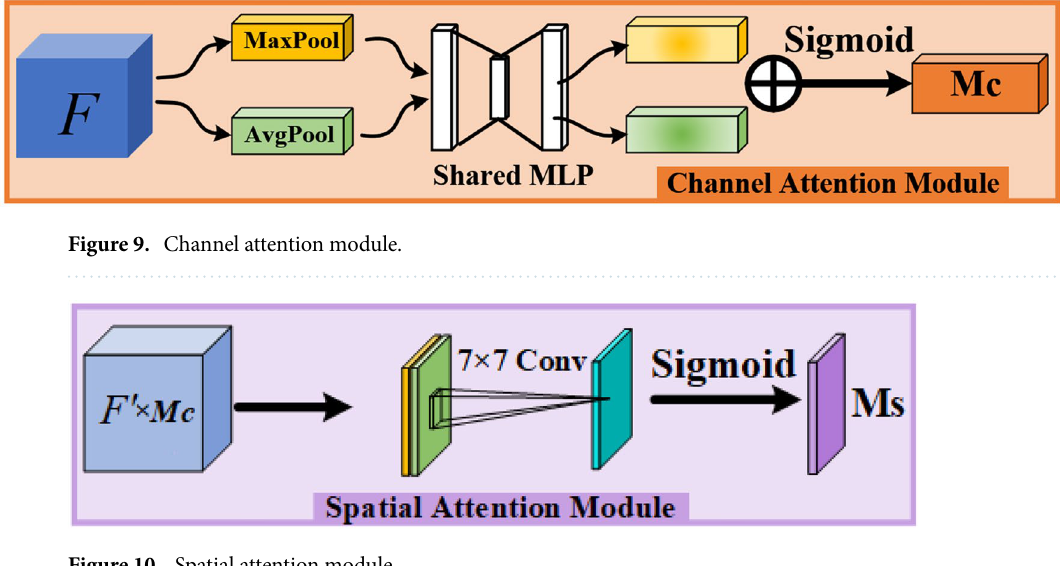
Figure 10. Spatial attention